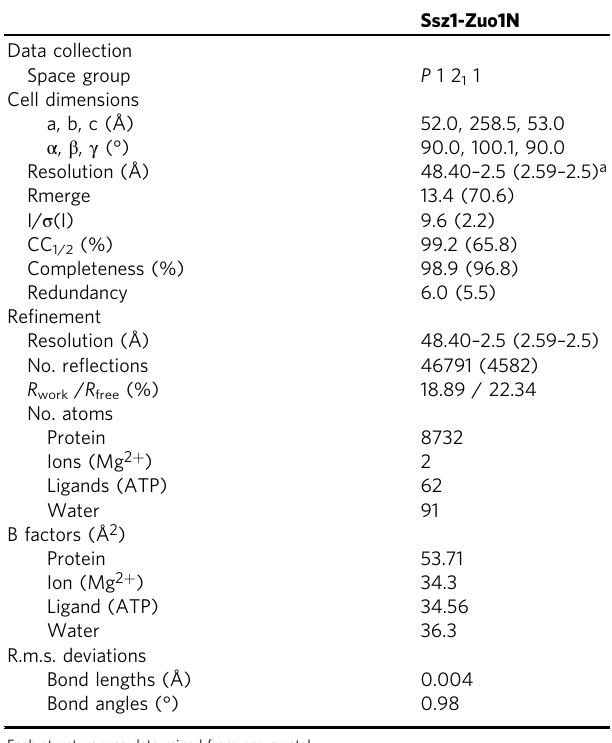
Table 1 Data collection and re fi nement statistics (molecular